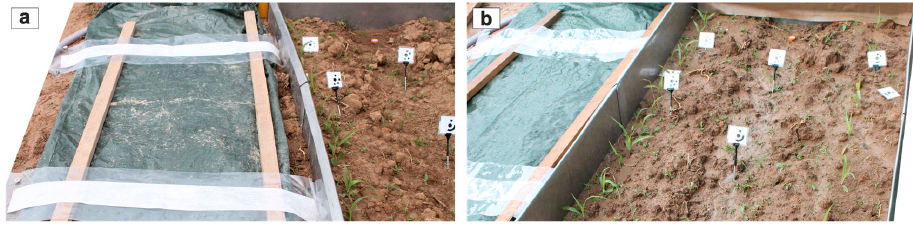
Figure 3. The experimental setup of the Nossen III-plot for the determination of splash before ( a ) and after ( b ) the